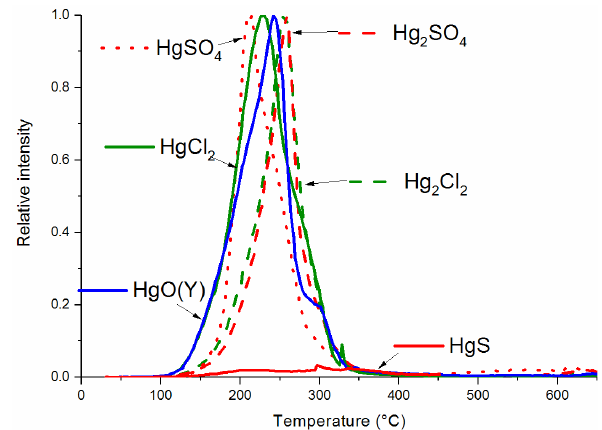
Figure 7: TPD spectra of mercury compounds in precipitate prepared by wet mixing various Hg-species in a solution of CaSO FeOOH. Note: The absence of HgS peak is due to its low solubility.